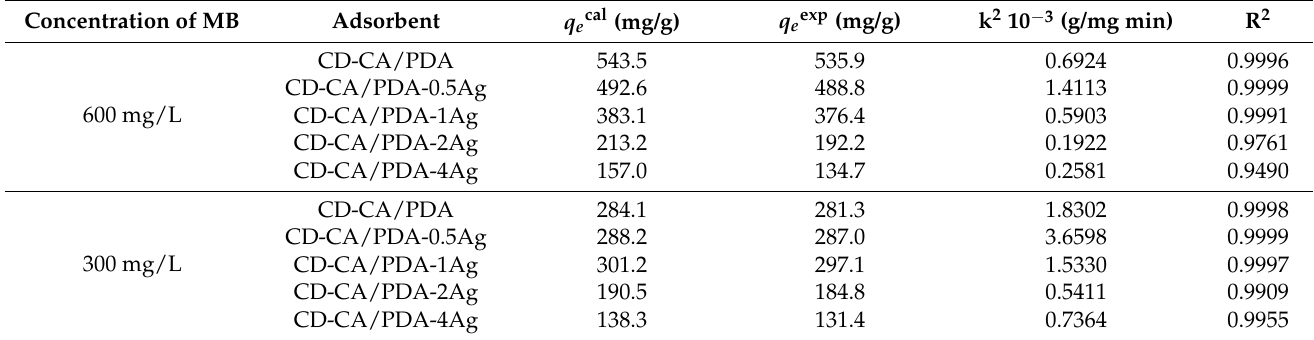
Table 2. Pseudo-second-order kinetic parameters for the adsorption of the initial MB concentrations of 600 mg/L and 300